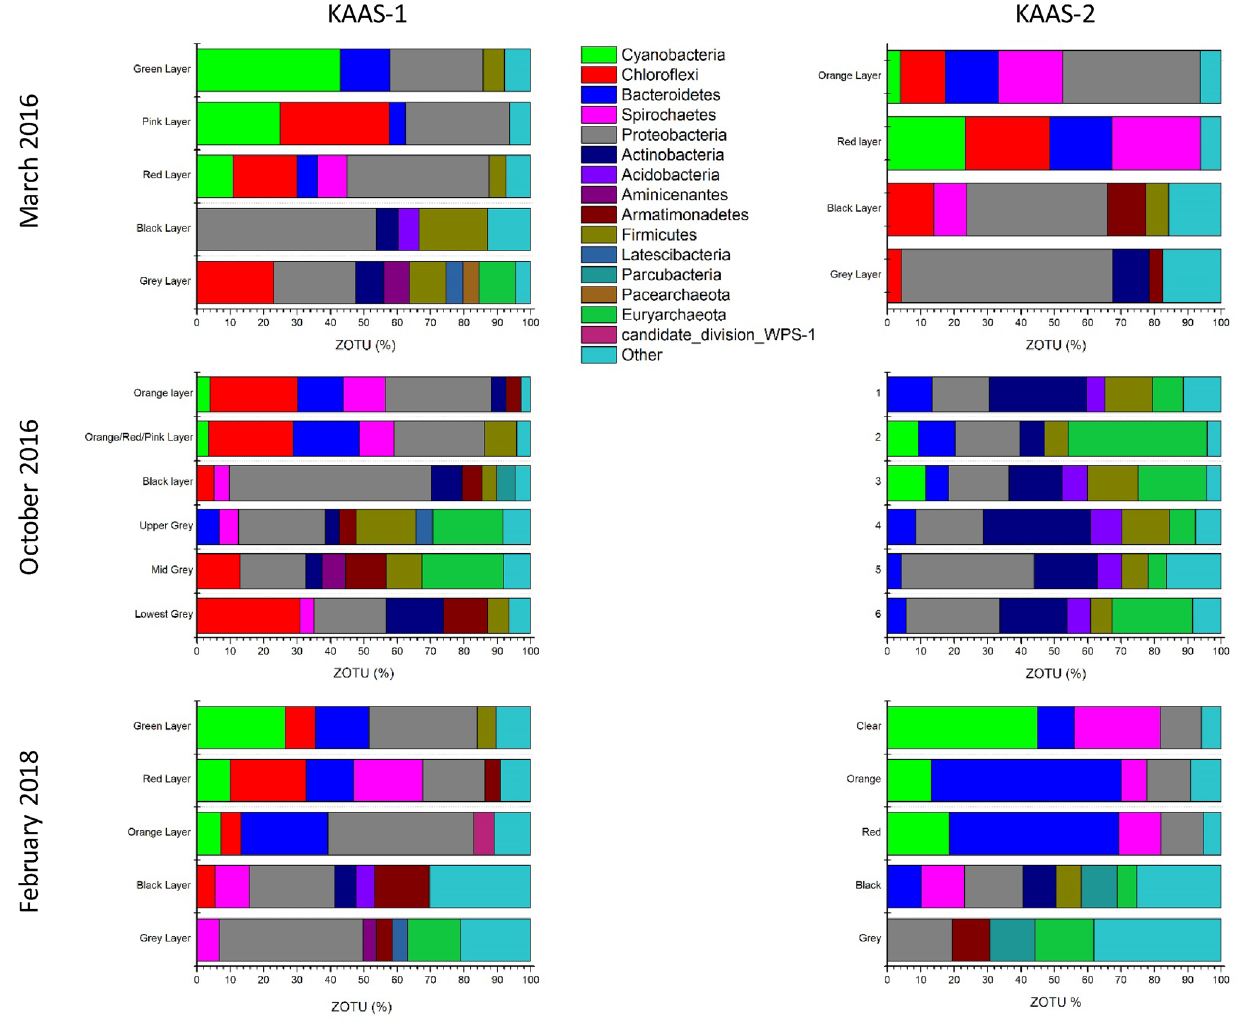
Figure 4. [Top]: Phylum level classification of 16 s rRNA ZOTU abundance (%) from KAAS-1 and KAAS-2 in March of 2016. [Middle]: Phylum level classification of 16 s rRNA ZOTU abundance (%) from KAAS-1 and KAAS-2 in October of 2016. [Bottom]: Phylum level classification of 16 s rRNA ZOTU abundance (%) from KAAS-1 and KAAS-2 in February of 2018.